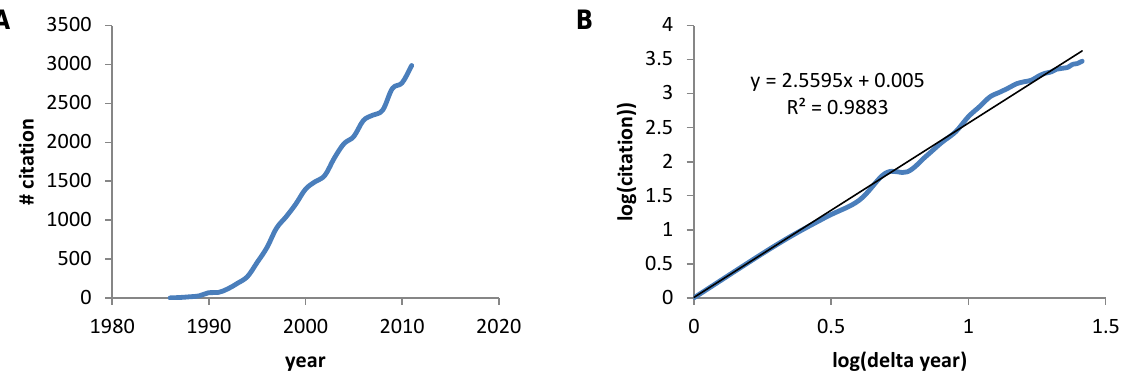
Figure 1. ( A ) The number of papers acquired via PubMed for the search term “neuroprotective” plotted verses the year. ( B ) A log transform of the plot in A where “years” is now expressed as the number of years with 1986 starting as year 1.